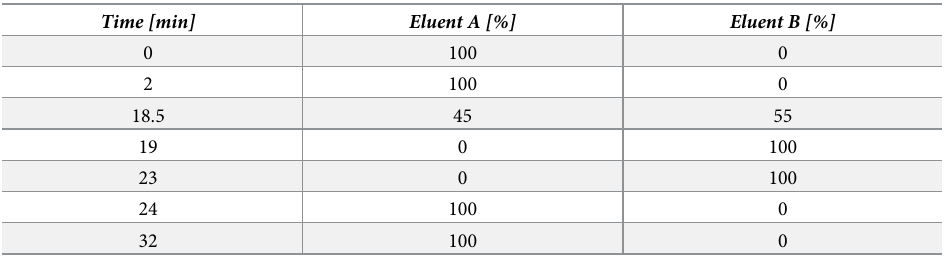
Table 2. Chromatographic method used for heparin affinity